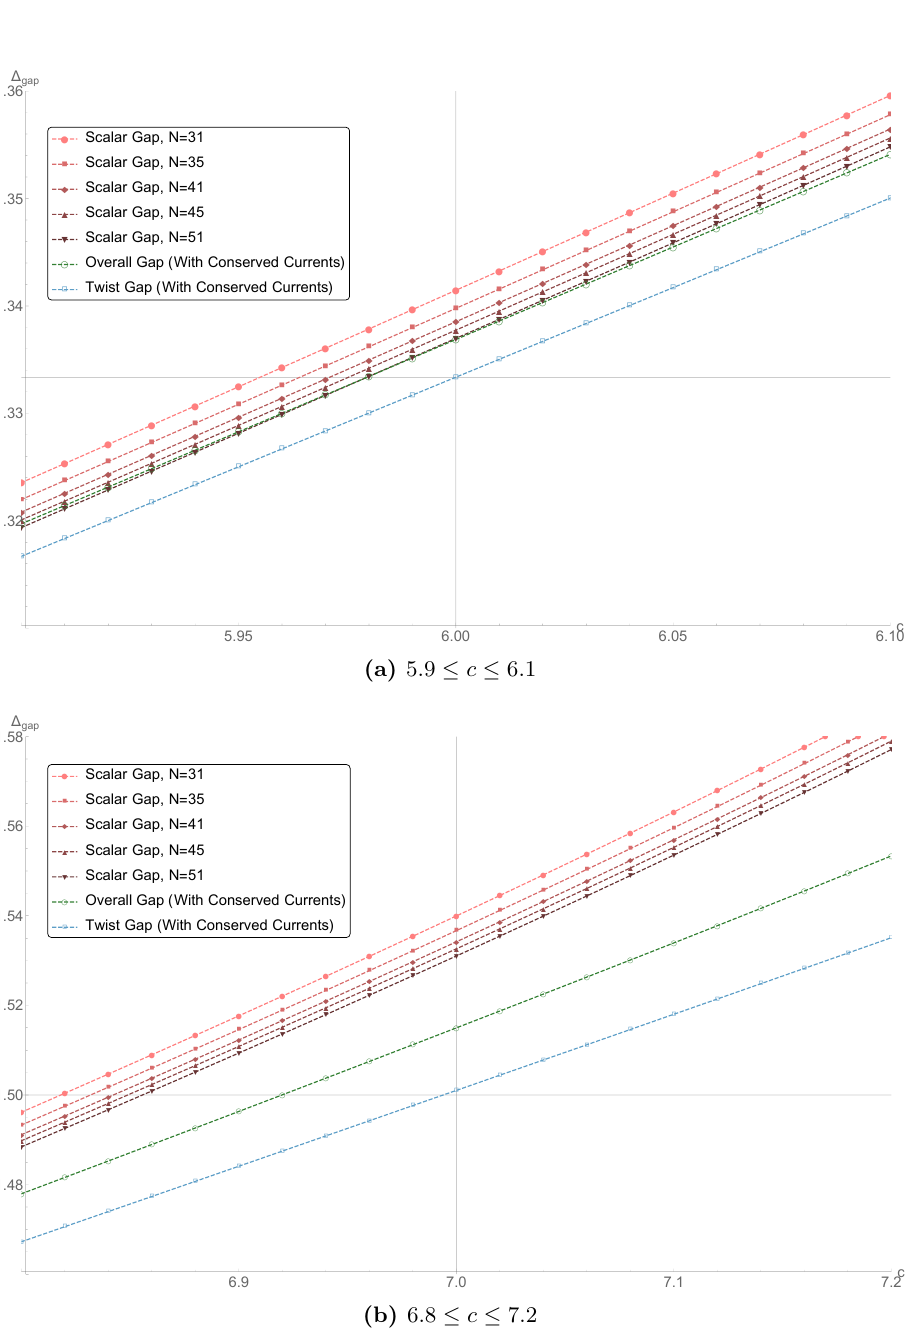
Figure 5. Numerical upper bounds on scalar gap, overall gap and twist gap zoomed in around c = 6 and